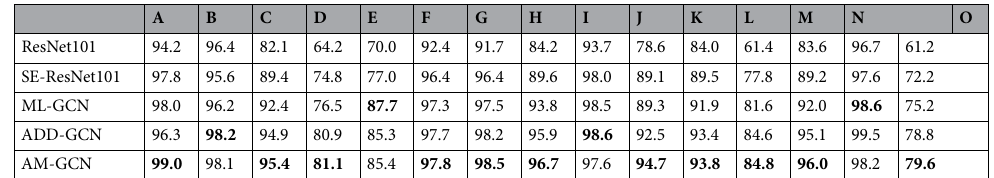
Table 1. Comparison of performance (%) between AM-GCN and other recognition